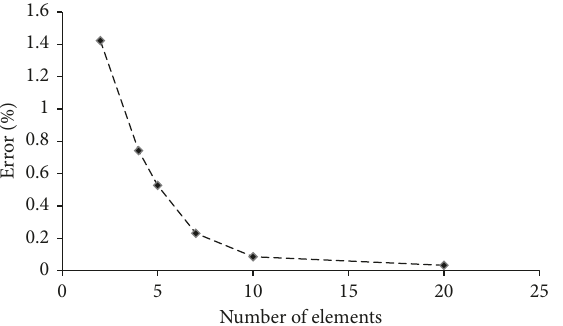
Figure 2: Convergence analysis for clamped-clamped isotropic beam, with P 0